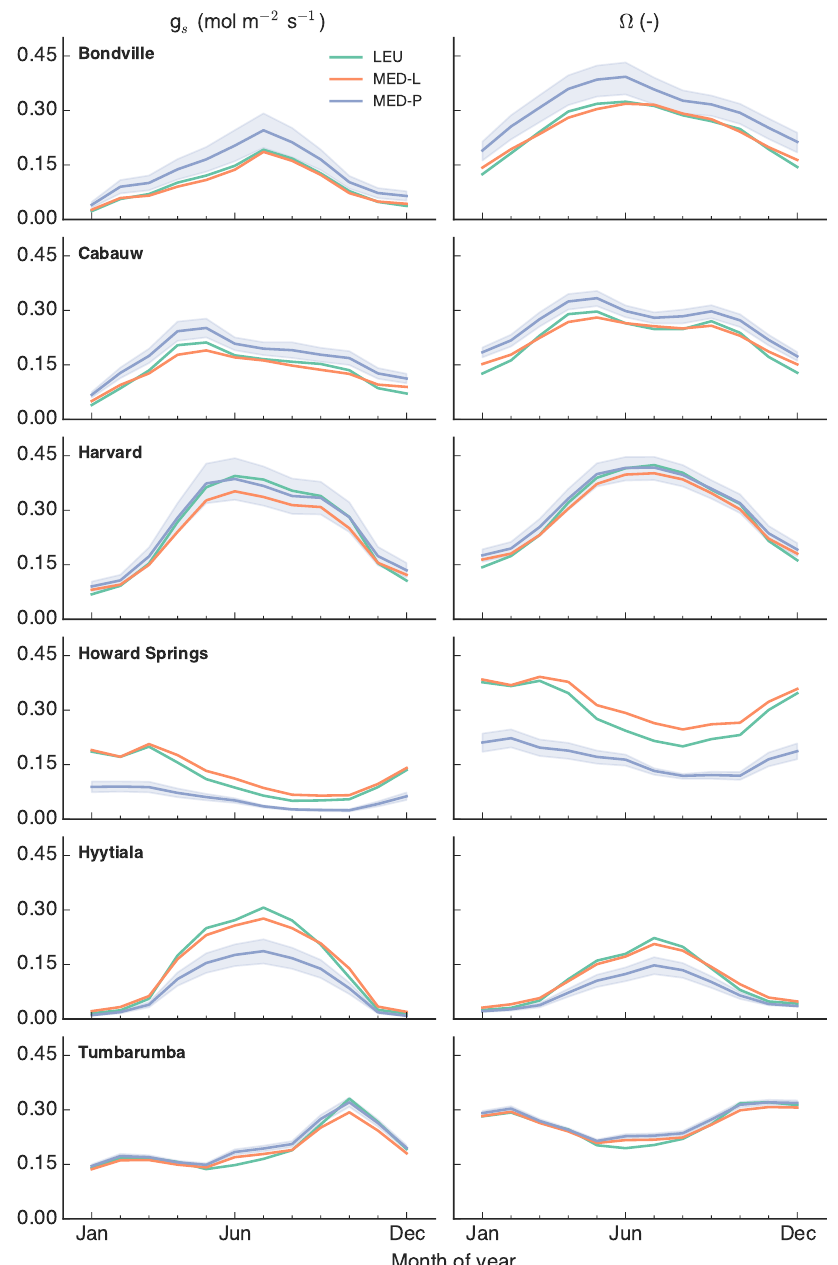
Figure 5. Average seasonal cycles of the simulated decoupling coefficient ( (cid:127)) , total boundary layer conductance ( g b ) and stomatal con- ductance ( g s ) at six FLUXNET sites during daylight hours (8a.m.–7p.m.). Time series have been averaged across all years as described in Table 2 to produce seasonal cycles. Light blue shading indicates the uncertainty in predicted fluxes from the Medlyn model (MED-P), accounting for ± 2 standard errors in the site g 1 parameter